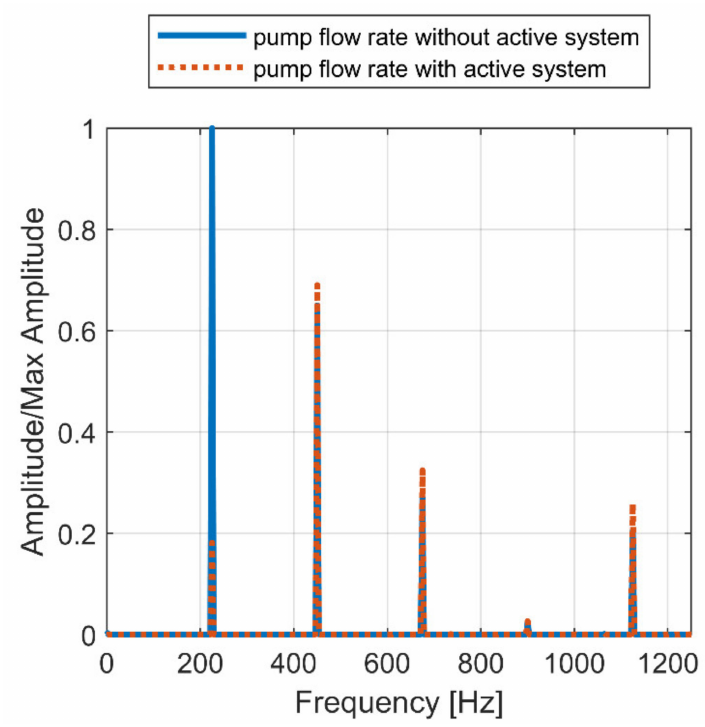
Figure 15. Simulation cycle 2, section 2: flow ripple FFT at 90 bar, 1500 rpm, 100% swash plate inclination.